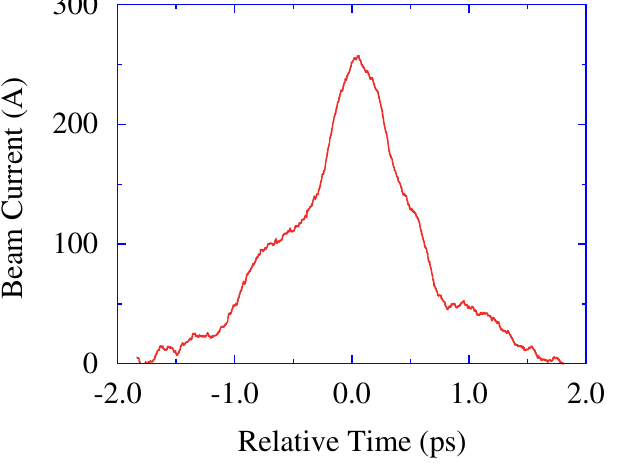
FIG. 13. (Color) Comparison of the measured pulse-energy de- pendence with that of the 3D SASE FEL simulations. Three values of the normalized-slice emittance ( 0 : 5 (cid:2) , 0 : 7 (cid:2) , and 0 : 9 (cid:2) mm mrad ) were assumed. The error bar indicates the uncertainty (30%) for the pulse-energy calibration.